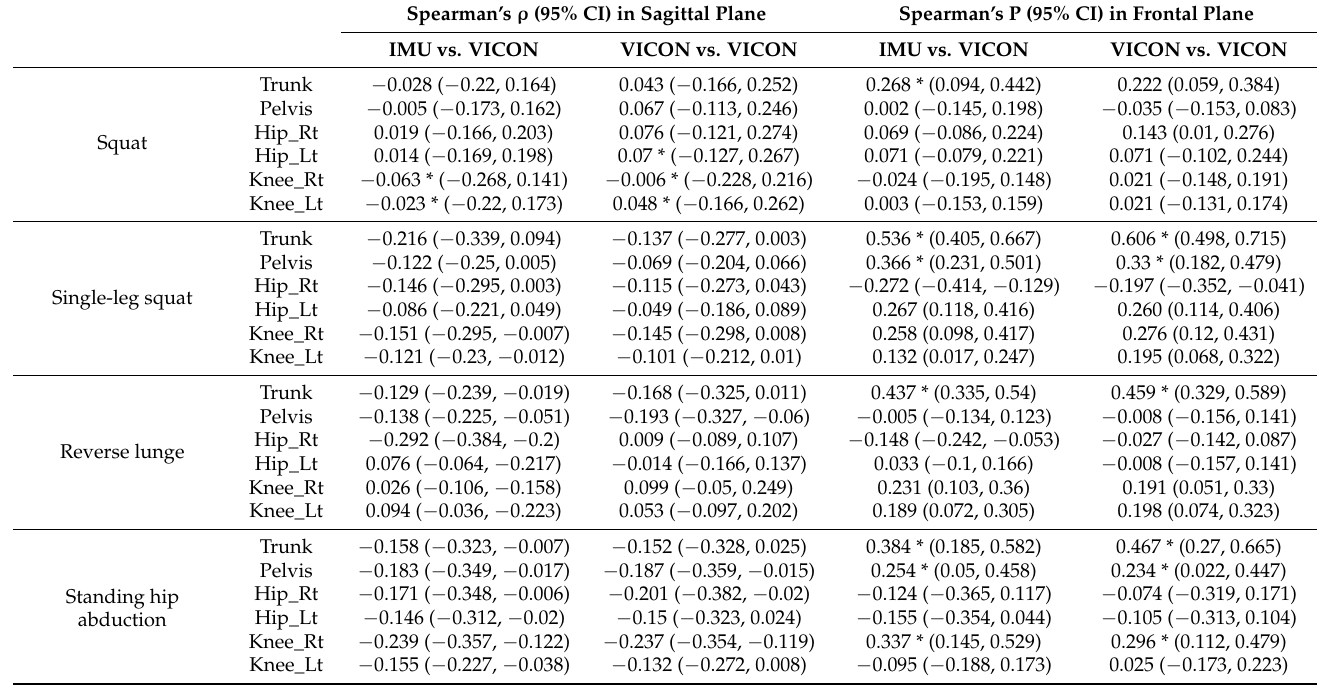
Table 3. Pairwise correlations between the head and other joints during workout